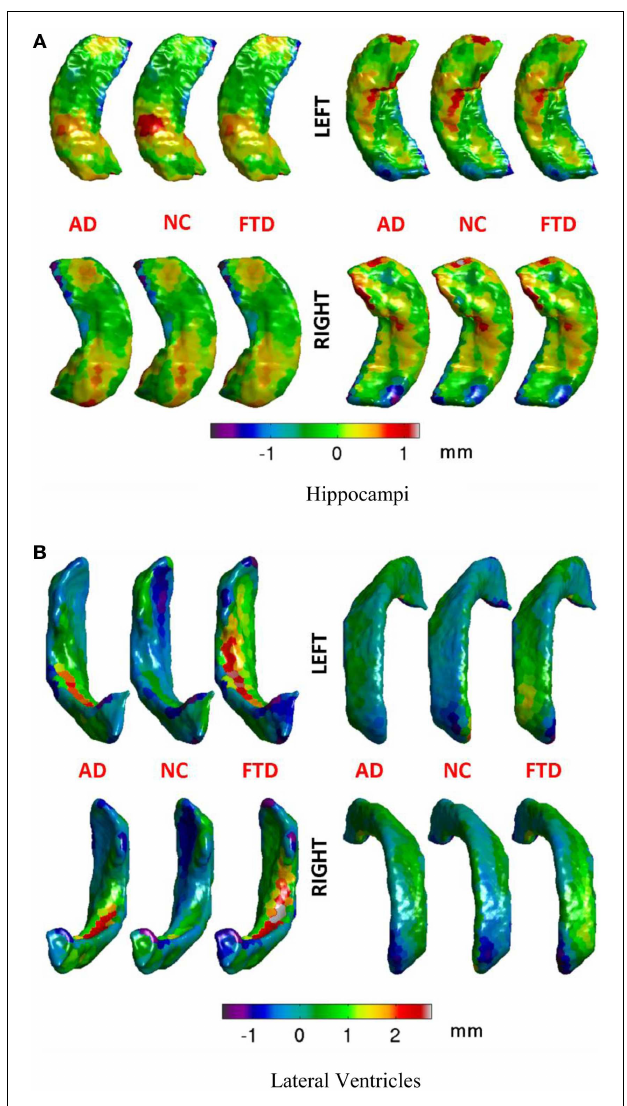
FIGURE 5 | Mean displacements in millimeters for different diagnostic groups are visualized on the average hippocampal and ventricular surfaces . (A) We can see that differences in the patterns of displacements in the three groups are rather similar.We will see in the results section that this similarity is reflected in rather poor predictive value by the hippocampal displacement features. (B) On the ventricular surface, we can see clear differences in the patterns of displacements in the three groups. For example, in the left lateral ventricle (top left), the ventricular expansion (positive displacement in red) in FTD is relatively more anterior compared to the ventricular expansion in AD (which is relatively posterior). Also, worth noting is the lack of ventricular expansion (negative displacement in blue at anterior head) in the control group compared to both AD and FTD, which is in accordance with our understanding of the atrophy caused by these diseases. Such focal differences in the ventricular displacements make it the most predictive biomarker as will be explained later in the results section. (A) Hippocampi, (B) lateral